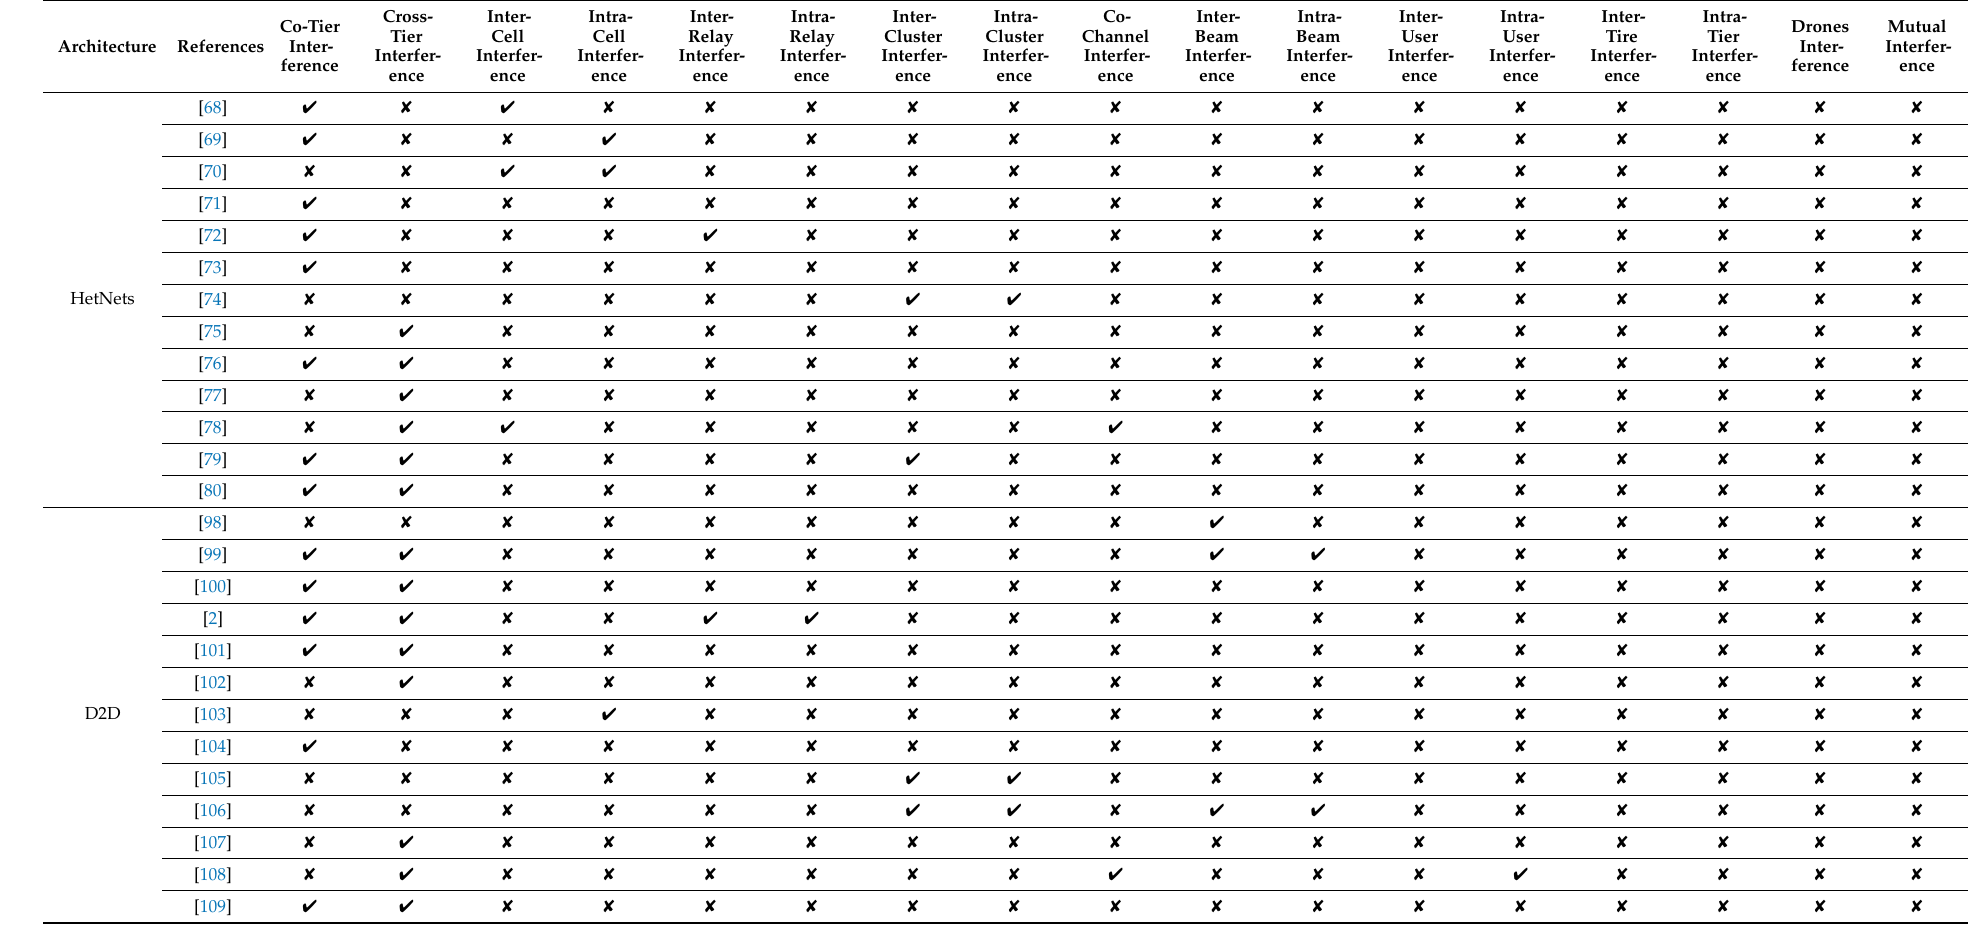
Table 6. The comparison of various strategies with respect to different types of